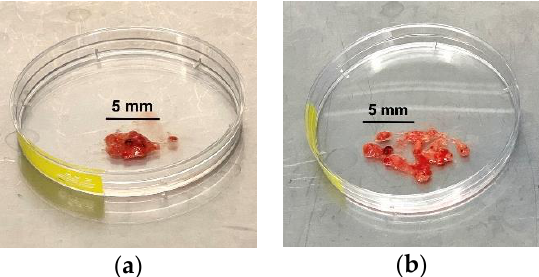
Figure 1. Fresh surgically resected human glioblastoma tissue ( a ) prior to and ( b ) after fragmentation with a surgical scalpel.